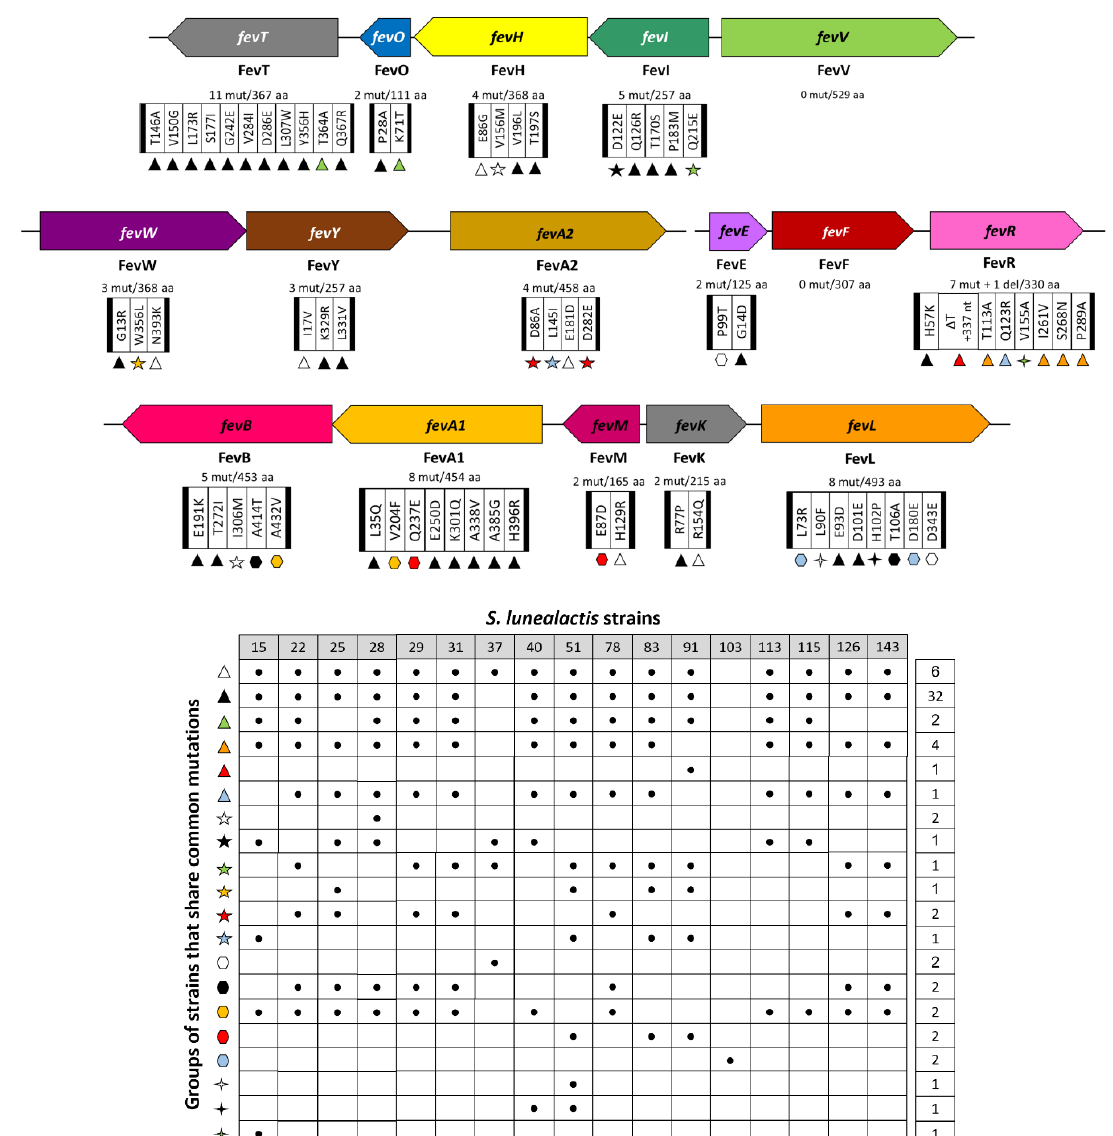
Figure 4. Mutations identified in genes of the bag / fev BGC in 17 S . lunaelactis strains. Top: illustration of the 16 genes of the bag / fev BGC and localization of the 66 mutations identified. Bottom table: symbols refer to the different groups of S . lunaelactis strains that share common mutations. Numbers in the bottom row: total number of mutations per strain compared to the type strain MM109T; Numbers in the right column: number of mutations associated with each symbol.